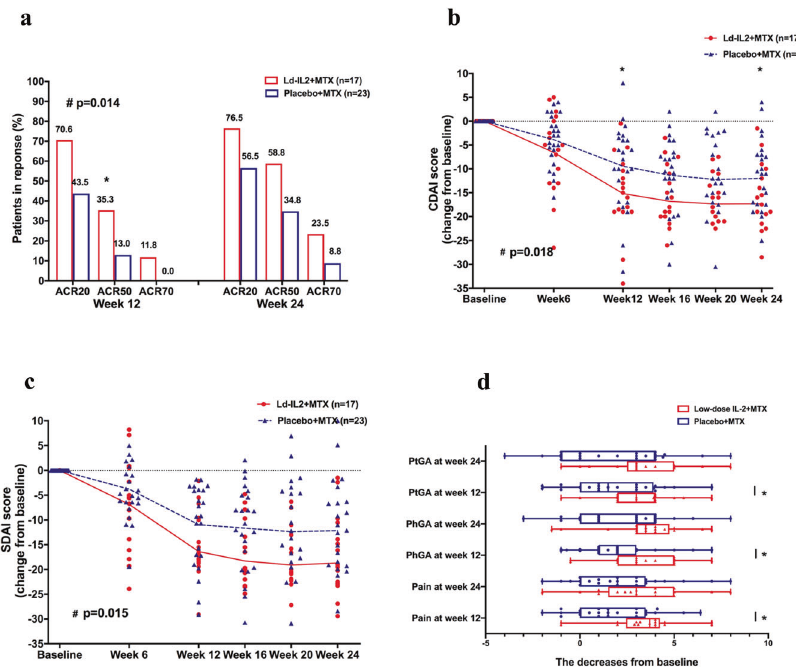
Fig. 2 Clinical responses to Ld-IL2 combined with MTX therapy. The data were presented in a per-protocol (PP) analysis set. The proportion of patients achieving an ACR20/50/70 response by at week 12 and 24 ( a ). The mean changes from baseline for CDAI and SDAI ( b, c ). The mean changes from baseline for pain, PtGA and PhGA of disease activity ( d ). Data in graphs were mean ± SE. * P < 0.05, with analyses with a logistic regression model or a covariance (ANCOVA) model at week 12 or 24. # P -value, presenting treatment differences across time points with a mixed model for repeated-measures analysis or Generalized Estimation Equations (GEE) method. ACR20/50/70 the American College of Rheumatology for 20%/50%/70% improvement, CDAI Clinical Disease Activity Index, SDAI Simpli fi ed Disease Activity Index, Ld-IL2 low-dose